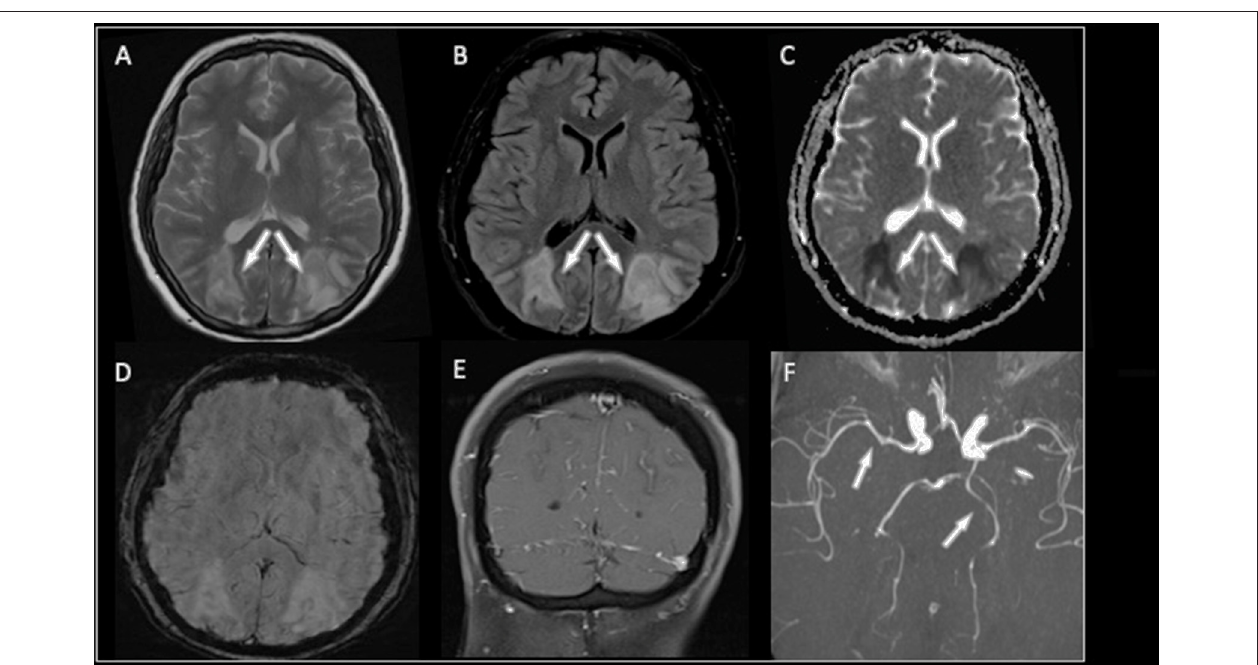
FIGURE 2 | The MR examination demonstrated the presence of cortical and subcortical T2-weighted and FLAIR hyperintensities involving both parieto-occipital lobes (A,B) . In this case, the lesions were characterized by diffusion restriction on the ADC map (C) findings consistent with cytotoxic edema. No hemorrhagic transformation or calcifications on SWI were seen (D) . After contrast medium administration, diffuse leptomeningeal enhancement was noted (E) . The MR angiography with 3D-TOF sequence (F) showed slight narrowing of the P2 segment of the left posterior cerebral artery and the M1 segment of the right middle cerebral